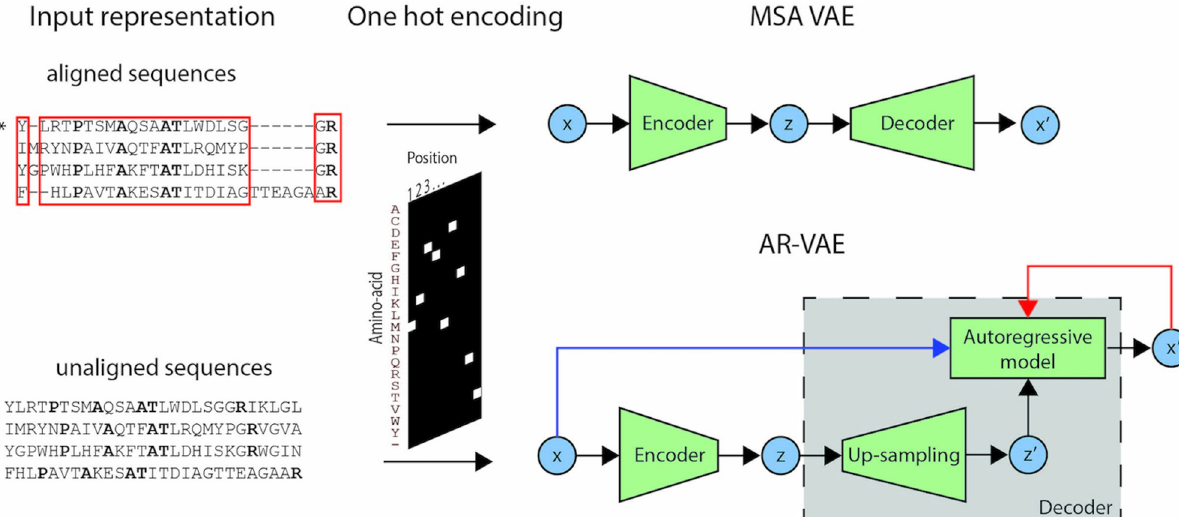
Fig 1. Schematic representation of the input representation and VAE models used in the study. Models take as input either raw or aligned sequences. In the latter case, the inputs correspond to the rows of an MSA of the luciferase family. Only columns of the MSA corresponding to positions (highlighted in red) present in the target protein (marked with � ) are retained. In both cases, the sequences are one-hot encoded before being fed into the model. Different architectures were used depending on the type of sequence input. The model developed to work with aligned sequences (MSA VAE) used fully-connected feed-forward networks in both the encoder and the decoder. The model developed to work with raw sequences (AR-VAE) comprised a CNN encoder and a decoder which combined upsampling with autoregression. The decoder sequentially outputs predictions for the identity of the amino acid at each point in the sequence, conditioned on the upsampled latent representation together with the previous amino acids in either the input sequence (during training, blue arrow) or the generated sequence (when being used generatively, red arrow).